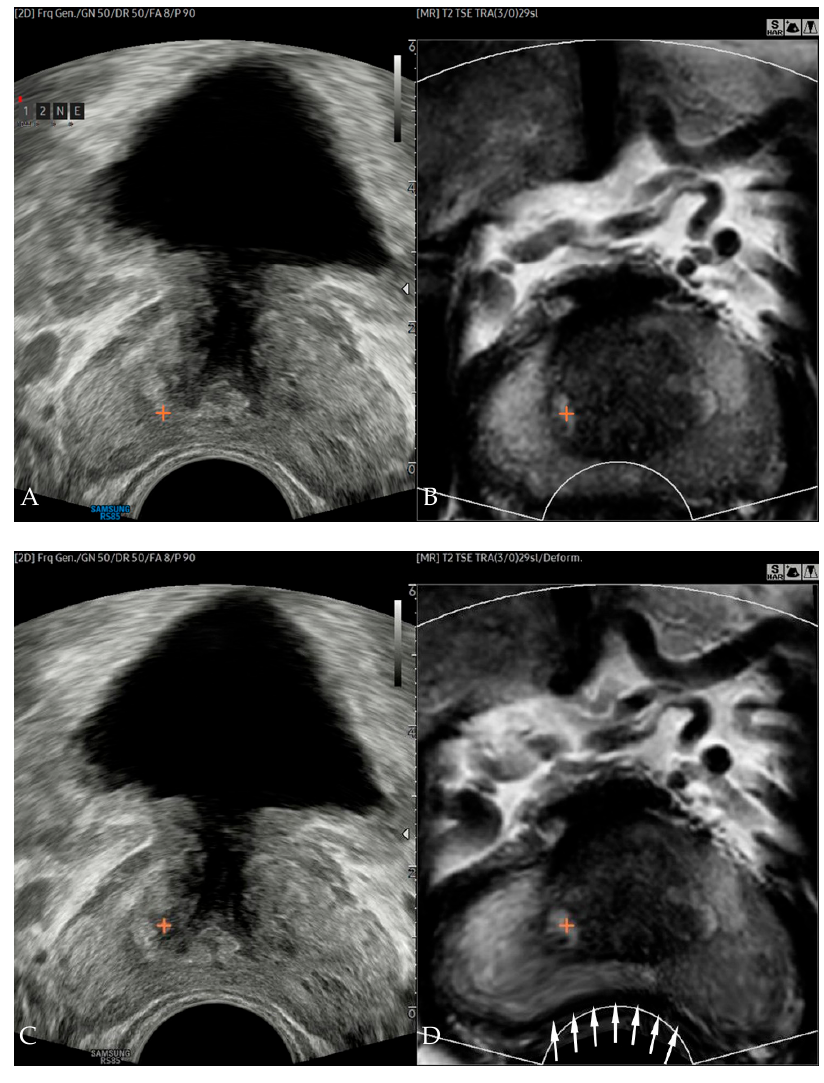
Figure 1. Side-by-side display of US ( A ) and MRI ( B ) of a 65-year-old male after rigid registration. Cross-mark drawn on MRI transferred to the corresponding point on US. Similar to the US ( C ) with a transrectal probe inserted, MRI ( D ) demonstrated concavely deformed posterior margin (arrows) after real-time corrected nonrigid registration. Internal image features of MRI were also deformed. Cross-mark selected on the deformed MRI also moved to its new corresponding point in the US.